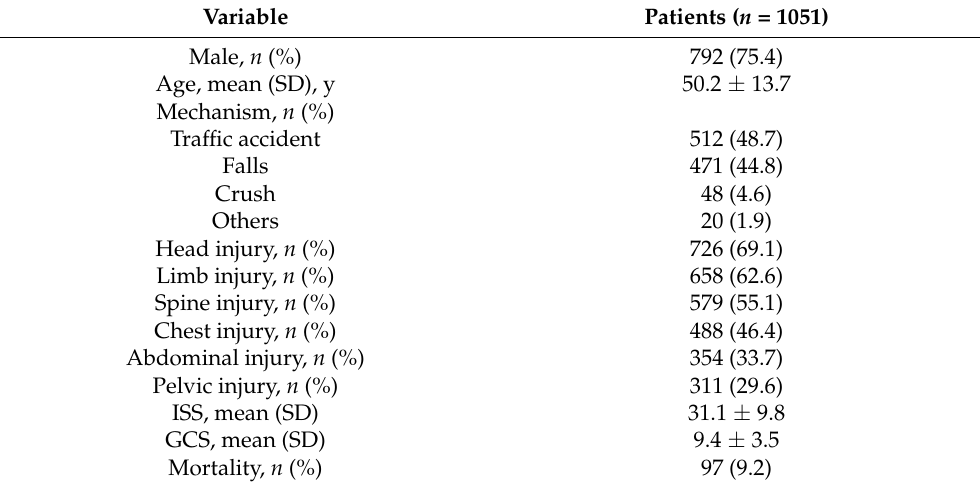
Table 1. Demographics and characteristics of polytrauma patients.